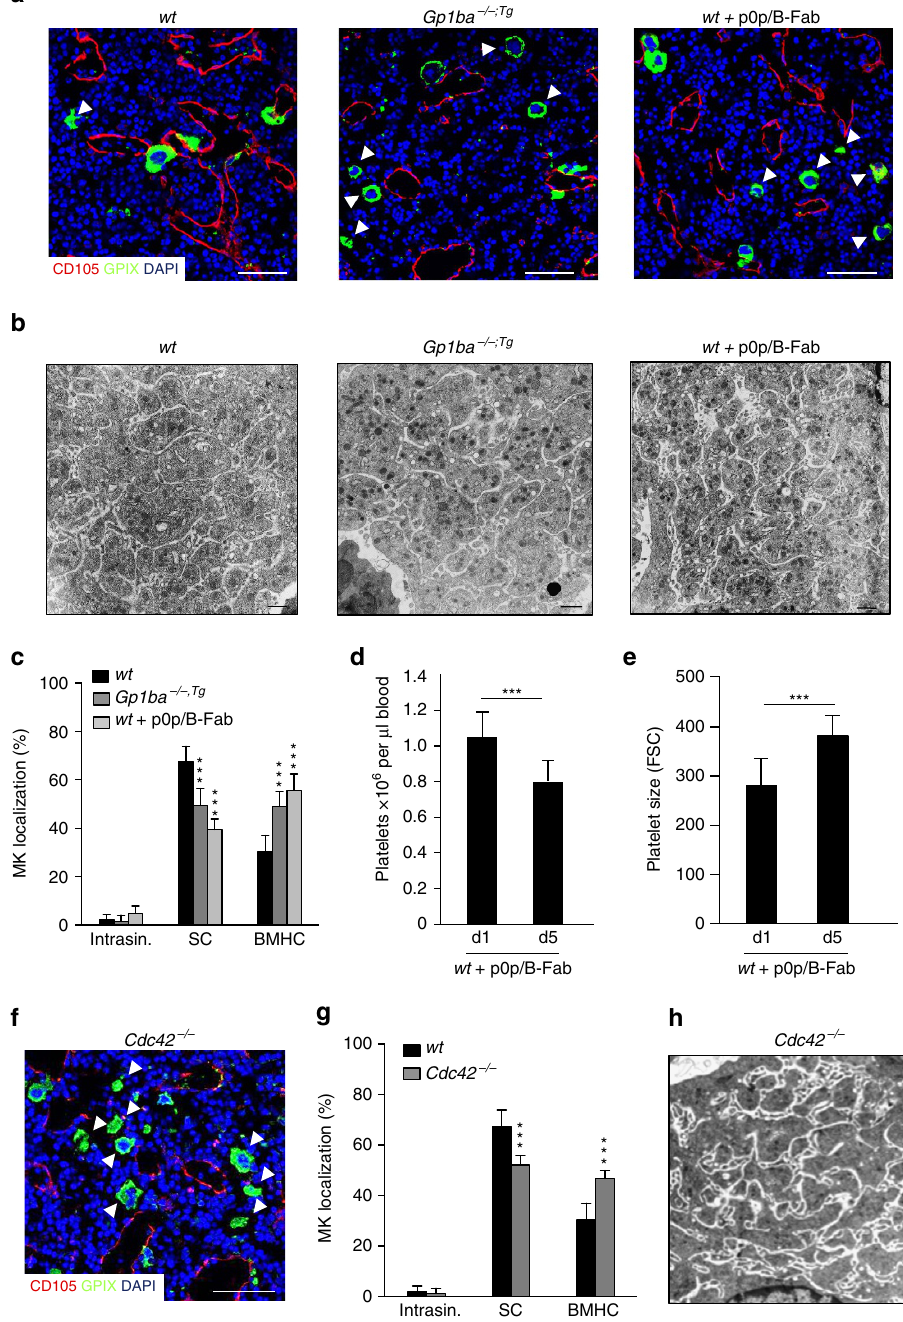
Figure 2 | GPIb a ectodomain and Cdc42 regulate MK localization in the BM. ( a ) Confocal images of immunostained BM and ( b ) TEM analysis of BM MKs of wt ( left panel ), Gp1ba (cid:2) / (cid:2) ;tg ( Gp1ba-Tg ) ( middle panel ) and wt mice after treatment with GPIb a -blocking monovalent Fab fragments, p0p/B-Fab ( right panel ). n ¼ 4 biological replicates. Scale bars, 50 m m ( a ) and 2 m m ( b ). MKs, proplatelets and platelets are shown by GPIX staining in green. Endoglin staining (red) labels vessels. DAPI, blue. Arrowhead indicates MKs in the BM haematopoietic compartment (BMHC). ( c ) Quantification of MK localization in the BM reveals less sinusoidal contact (SC) in Gp1ba-Tg (dark grey) and wt mice after GPIb a -blockade (light grey) compared to the wt (black) ( n ¼ 7, 5 and 10); intrasinusoidal (intrasin.). ( d , e ) Reduced platelet count ( d ) and increased platelet size ( e ) in wt mice after GPIb a -blockade ( n ¼ 4). ( f ) Representative confocal images of immunostained BM of Cdc42 (cid:2) / (cid:2) mice. Scale bar, 50 m m. ( g ) Quantification of MK localization in the BM reveals reduced SC in wt (black) and Cdc42 (cid:2) / (cid:2) (grey) mice ( n ¼ 10 and 3). ( h ) TEM analysis of BM MKs of Cdc42 (cid:2) / (cid:2) mice. Scale bar, 2 m m. Bar graphs represent mean ± s.d. ( c , g ) Two-way ANOVA with Bonferroni correction for multiple comparisons; ( d , e ) Unpaired two-tailed Student’s t -test; *** P o